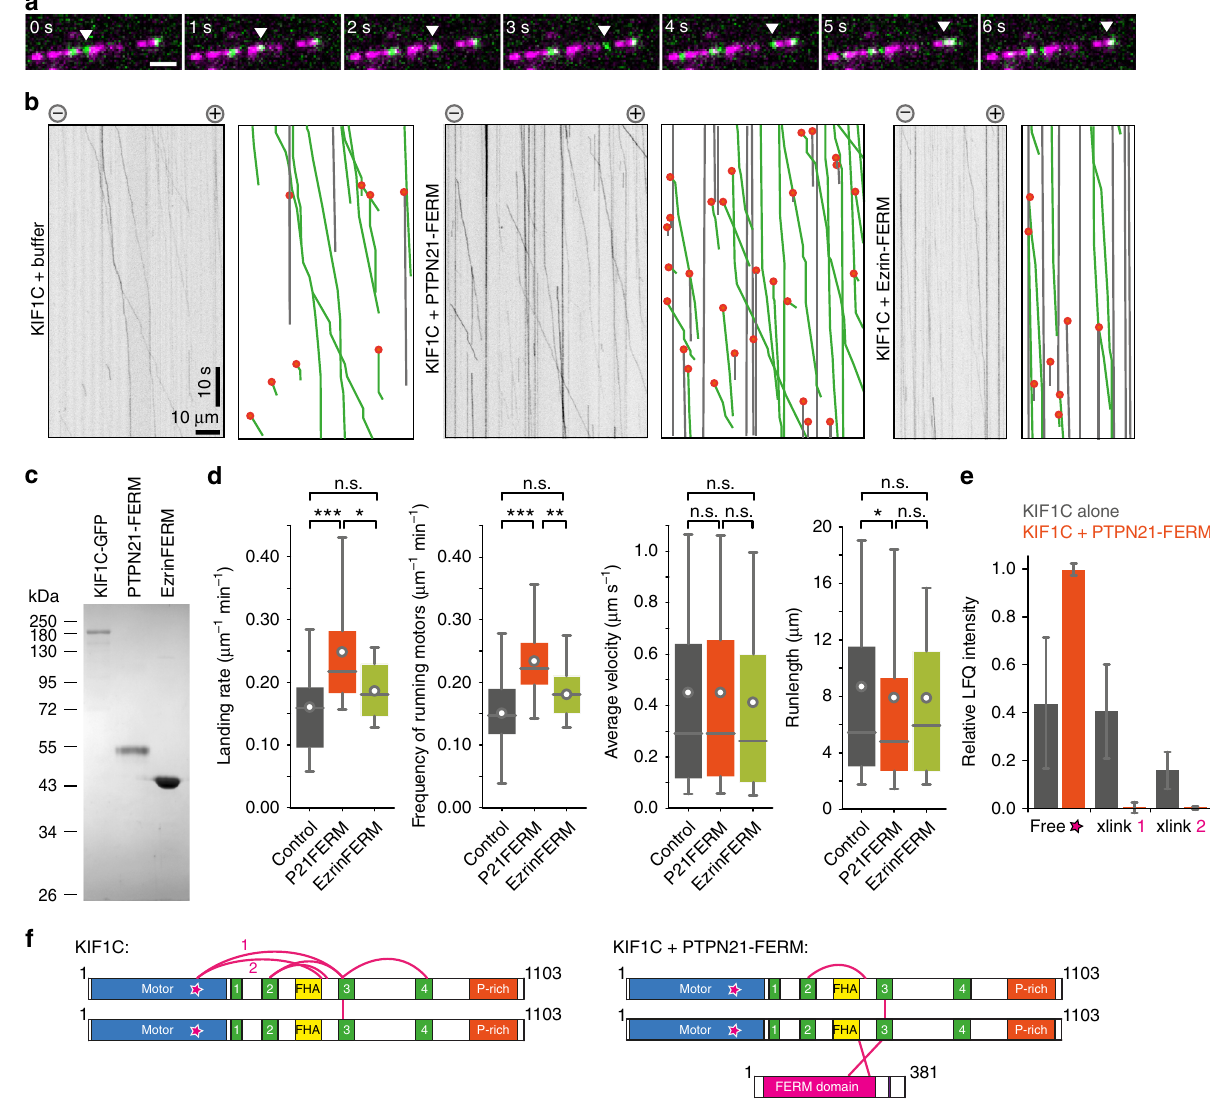
Fig. 5 PTPN21 FERM domain activates KIF1C in vitro. a KIF1C-GFP (green) is a processive motor in single-molecule assays on Taxol-stabilised microtubules (magenta). Scale bar 2 µ m. b Representative kymographs from single-molecule experiments of KIF1C in the presence of FERM domains of PTPN21 and Ezrin. Grey lines indicate immobile motors; green lines running motors and orange dots landing events. c Coomassie-stained SDS-PAGE of puri fi ed KIF1C- GFP and FERM domains of PTPN21 and Ezrin. d Quanti fi cation of landing rate, frequency of running motors (>25 nm/s), average velocity and run length. n = 30, 39 and 21 microtubules respectively from three independent experiments. * p < 0.05, ** p < 0.005, *** p < 0.0005, n.s. p > 0.05 ( t -test with Bonferroni correction). Data are provided in Source Data fi le. e , f Crosslinking mass spectrometry of KIF1C in the presence of PTPN21-FERM identi fi ed two crosslinks between KIF1C and the FERM domain. Crosslinks in KIF1C alone are shown for comparison. Star indicates peptide in motor domain that is found in crosslinks with stalk domain (labelled 1 and 2). Relative abundance of single peptide LKEGANINK (star) and the two crosslinked peptides between motor and stalk domain are shown for KIF1C alone and KIF1C + PTPN21-FERM. Data show mean ± SD for three independent experiments. See Supplementary Figs. 2, 3 and 5 for ion fragmentation spectra. Data are provided in Source Data fi